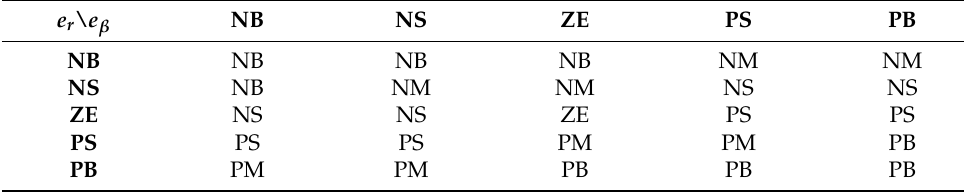
Table 4. Fuzzy Control Fuzzy Rule